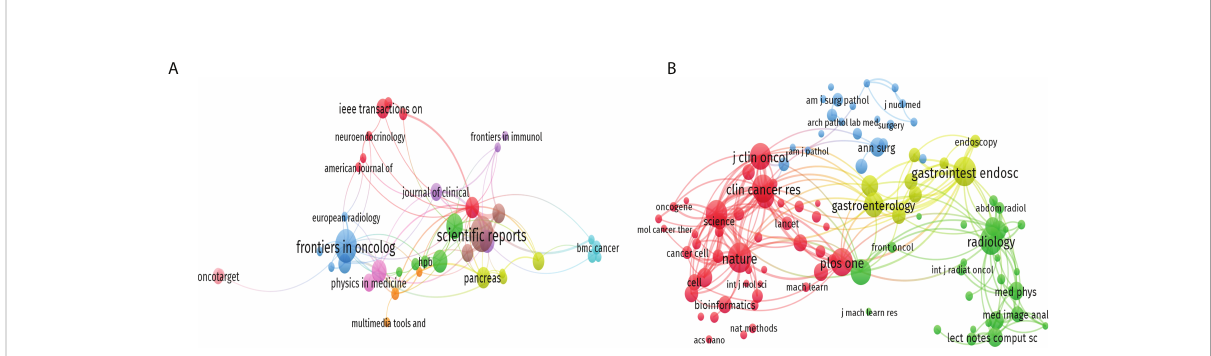
FIGURE 5 The citation and co-citation analysis of journal. (A) Network map of citation analysis of journals with more than three publications. (B) Network map of co-citation analysis of journals with more than fi fty citations.